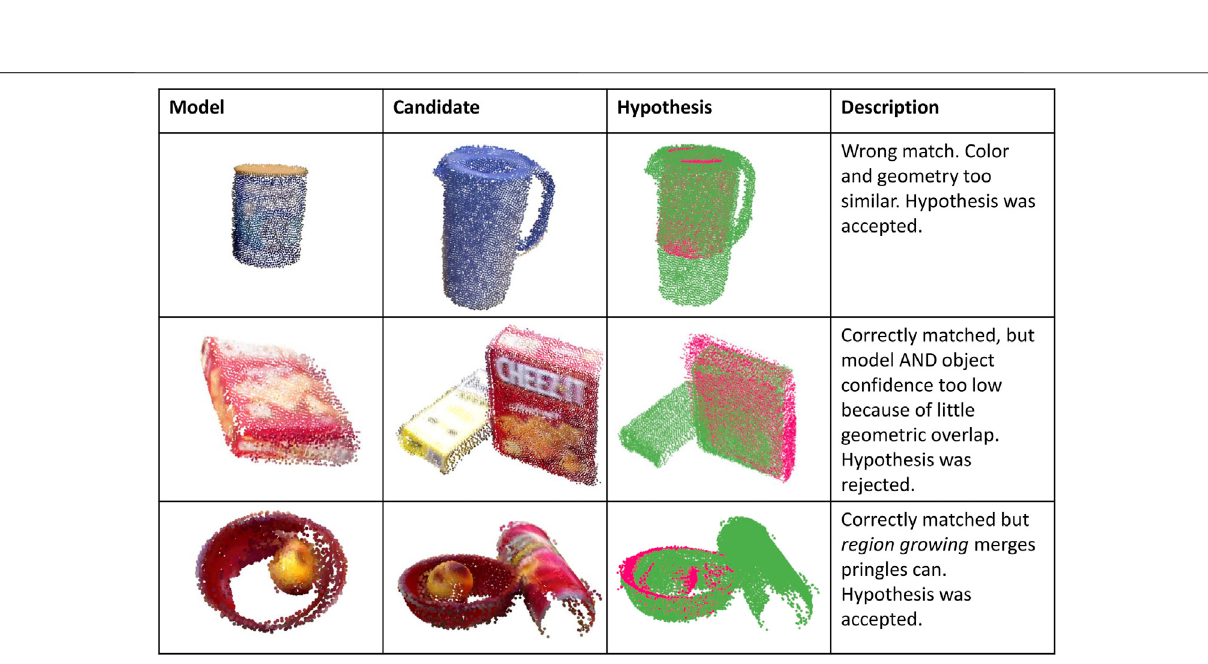
FIGURE 9 | Examples of hypotheses generated based on